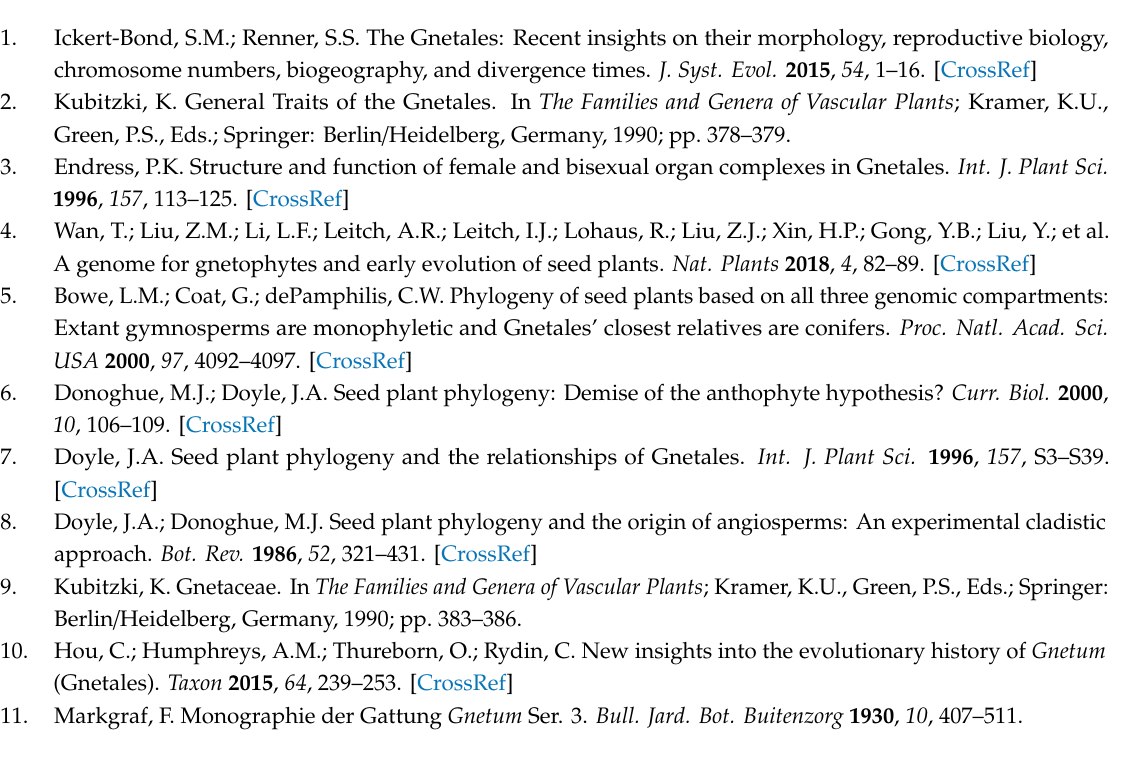
Figure S1: ROI and FLNC length distribution; Table S1: Primer information of Aux / IAA genes and qRT-PCR protocol; Table S2: All transcripts annotated by searching against varied databases; Table S3: Gene families and transcript information annotated by searching the Pfam database; Table S4: Alternative splicing events and location sites on the reference genome of G. luofuense ; Table S5: Information of polyadenylation events detected from G. luofuense female strobili; Table S6: lncRNAs and corresponding cis-regulated genes; Table S7: LncRNAs and corresponding cis-regulated